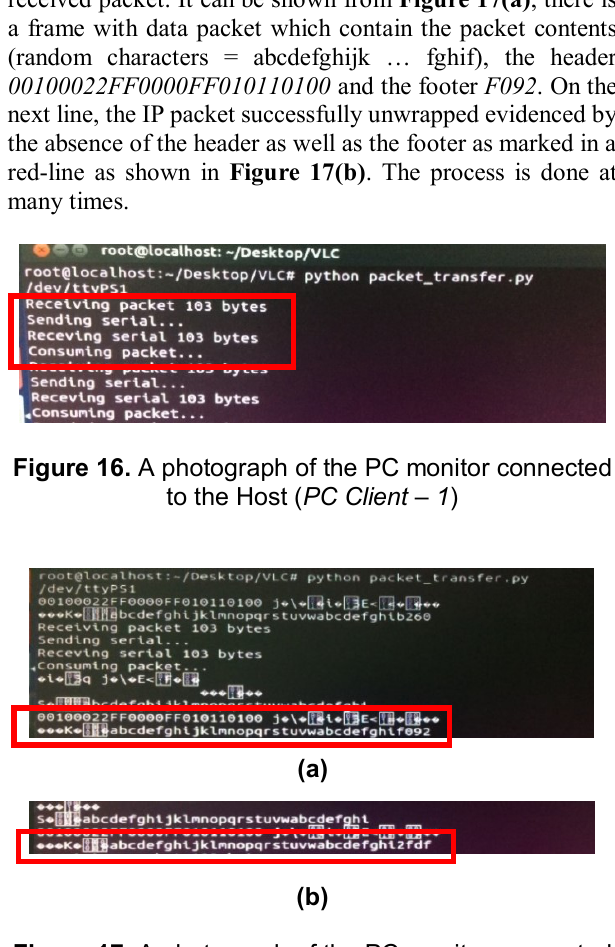
Figure 17. A photograph of the PC monitor